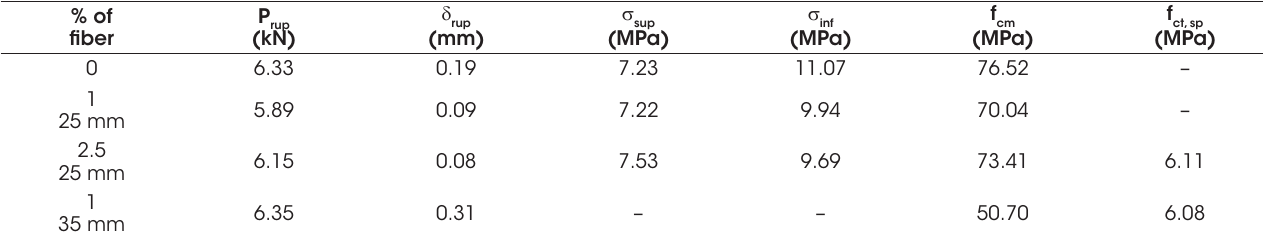
Mean values of the concrete beams test results